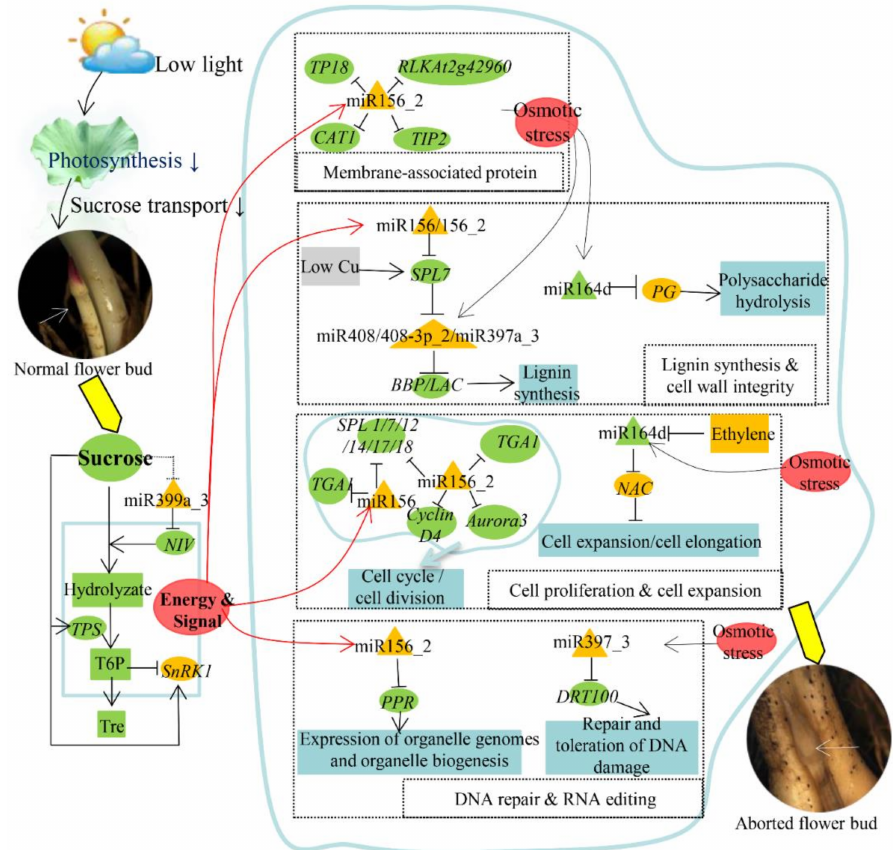
Figure 8. miR156-mediated potential mechanism of lotus flower bud abortion under low light. Under low-light conditions, the photosynthesis of lotus plants is weakened, and the sucrose transported from leaves to flower buds is reduced, eventually causing flower buds to die due to starvation. During the abortion process of flower buds, a series of miRNAs are involved. Among them, miR156 family plays central role—by sensing sugar signals, it regulates the target genes and participates in many aspects related to the growth and development of flower buds together with other miRNAs (such as miR408, miR397, and miR164) and their targets, including sugar metabolism, cell wall integrity, the activity of biomembranes, cell proliferation/expansion, and so on. Abbreviation: NIV , Beta-fructofuranosidase, soluble isoenzyme I-like; TPS , Trehalose-6-P synthase; SnRK1 : Sucrose non- fermenting-1-related protein kinase 1; Tre , Trehalose; TP18 , Transmembrane protein 18; CAT1 , cationic amino acid transporter 1-like; RLKAt2g42960 , probable receptor-like protein kinase At2g42960; TIP2 : Aquaporin Tonoplast Intrinsic Protein2-1; BBP , Basic blue protein-like gene; LAC , Laccase gene; PG , Polygalacturonase-like gene; SPL , Squamosa promoter-binding-like protein; TGA1 , Teosinte glume architecture 1; Cyclin D4 , Cyclin-D4-1-like; Aurora3 , Aurora-3 gene; NAC , NAC domain transcription factor target genes; PPR , Pentapeptide repeat proteins; DRT100 , DNA-damage-repair/toleration protein DRT100-like; Low Cu, Low Copper